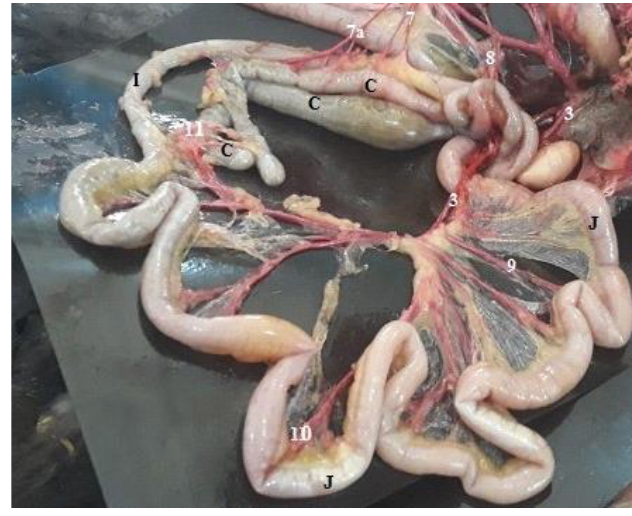
Figure 6 . Photograph illustrate blood supply of the jejunum , I:ileum , C:ceca 3:cranial mesenteric a ,7,7a:ileocecal arteries, 11:cecal branch fromjejunal a. .9:jejunal branches a.10:marginal a.